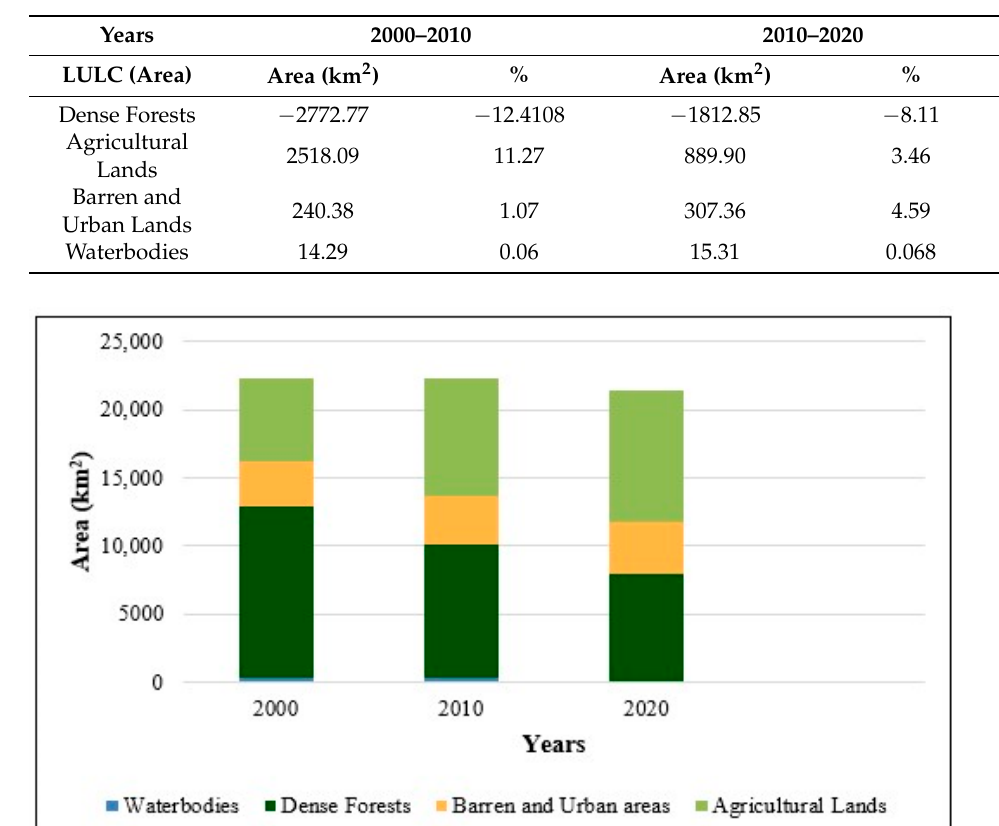
Table 5. Changes in area and percentage cover of LULC classes between the years 2000–2010, and 2010–2020 of the Perak River basin.